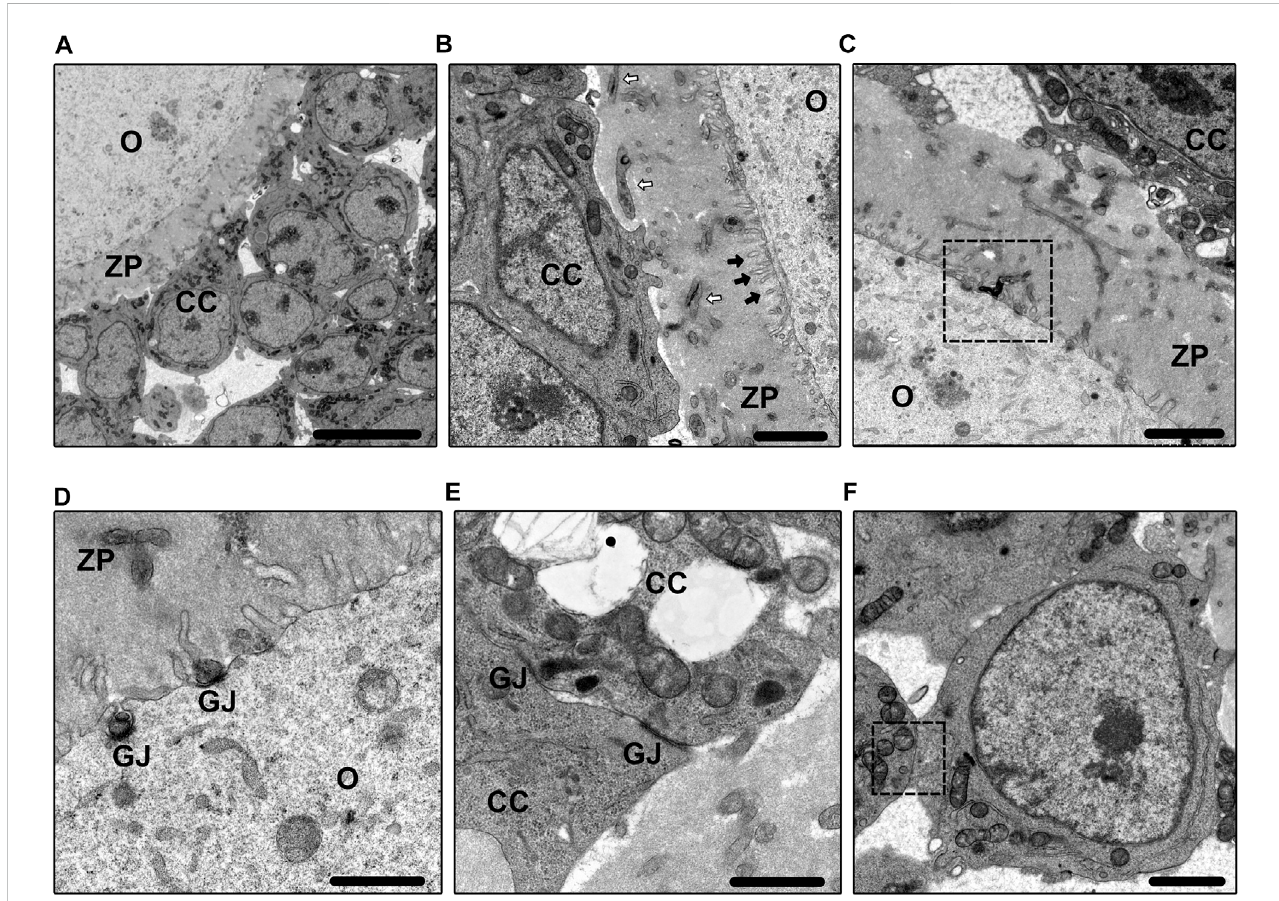
FIGURE 2 Electron microscope images. Figure 2A shows the basic morphology of COC in the primary follicle. Bar = 10 µm. Figure 2B shows the morphology of TZPs (whitearrows)andmicrovilli(black arrows). Bar=2 µm. Figure2C showstheclumped phenomenonbetweenTZPs andmicrovilli.Bar=2 µm.Figure 2D shows the morphology of GJs between TZPsand oocyte. Bar = 1 µm. Figure2E shows themorphology of GJs between CCs. Bar = 1 µm. Figure2F shows the cell membrane fusion between CCs. Bar = 2 µm. O, oocyte; CC, cumulus cell; ZP, zona pellucida; TZP, transzonal projection; GJ, gap